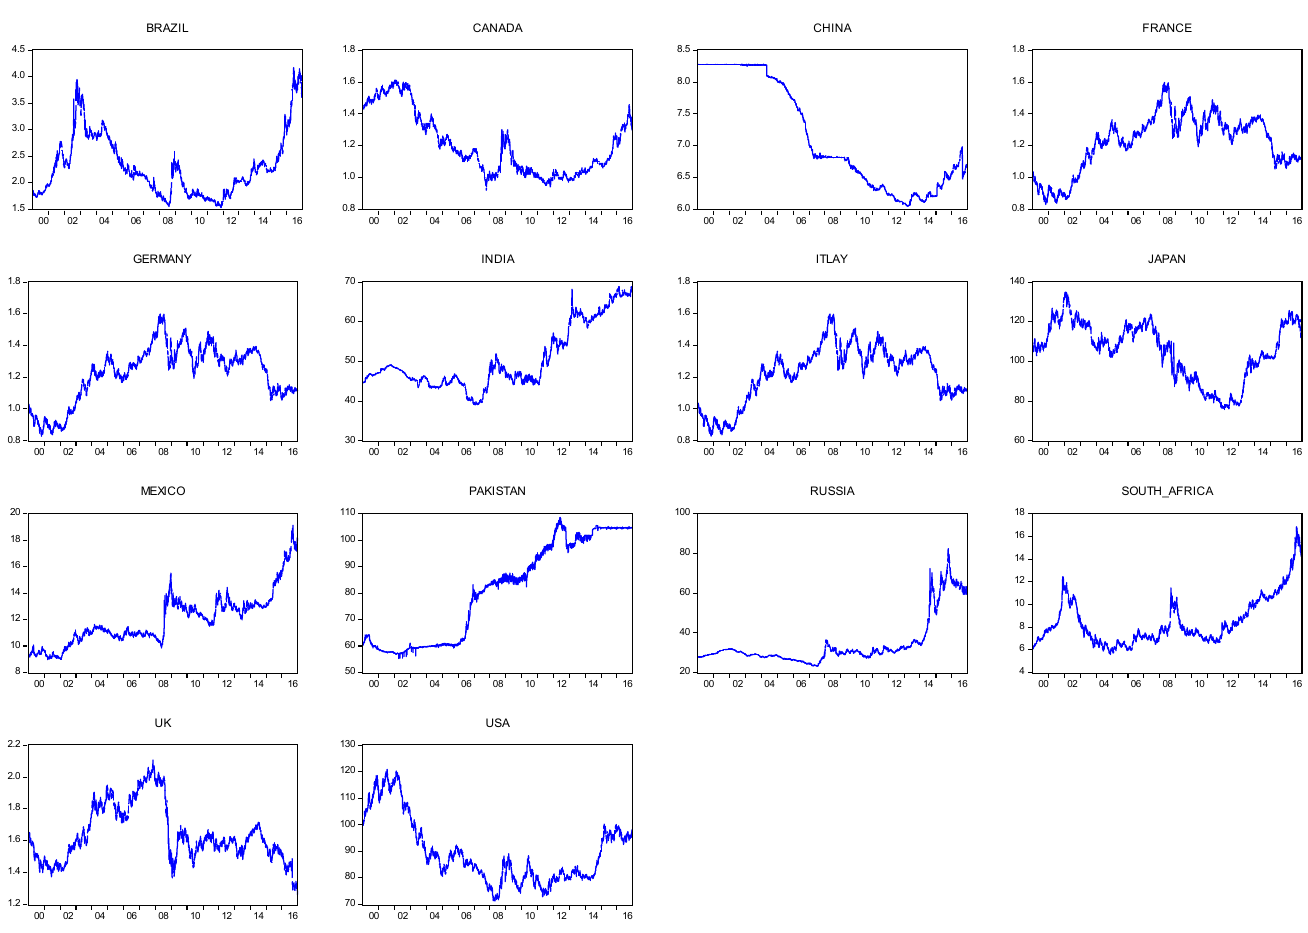
Figure A2. Graph of exchange rates of sample countries.